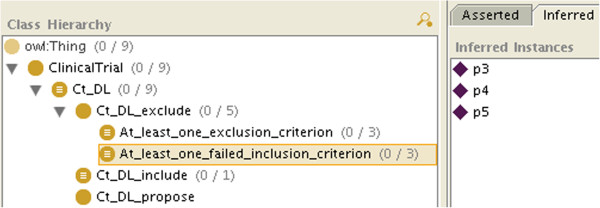
The class modeling clinical trial exclusion because at least one of the inclusion criteria failed to be met after classification (here patientsp3,p4 andp5 match the definition).